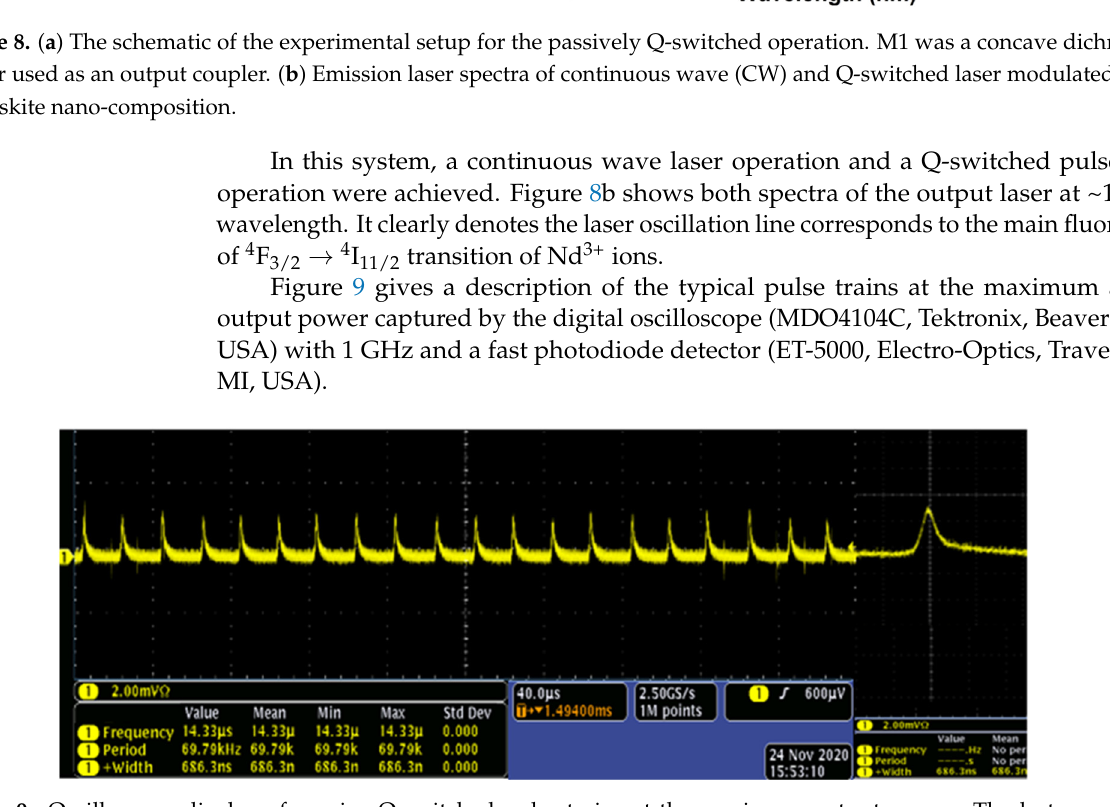
Figure 9. Oscilloscope display of passive Q-switched pulse trains at the maximum output power. The last one is a magnifying single pulse.